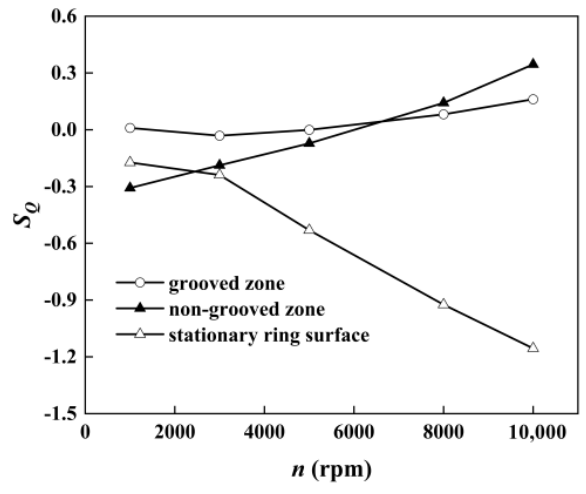
Figure 18. Relationship between S Q of different parts and the rotating speed.